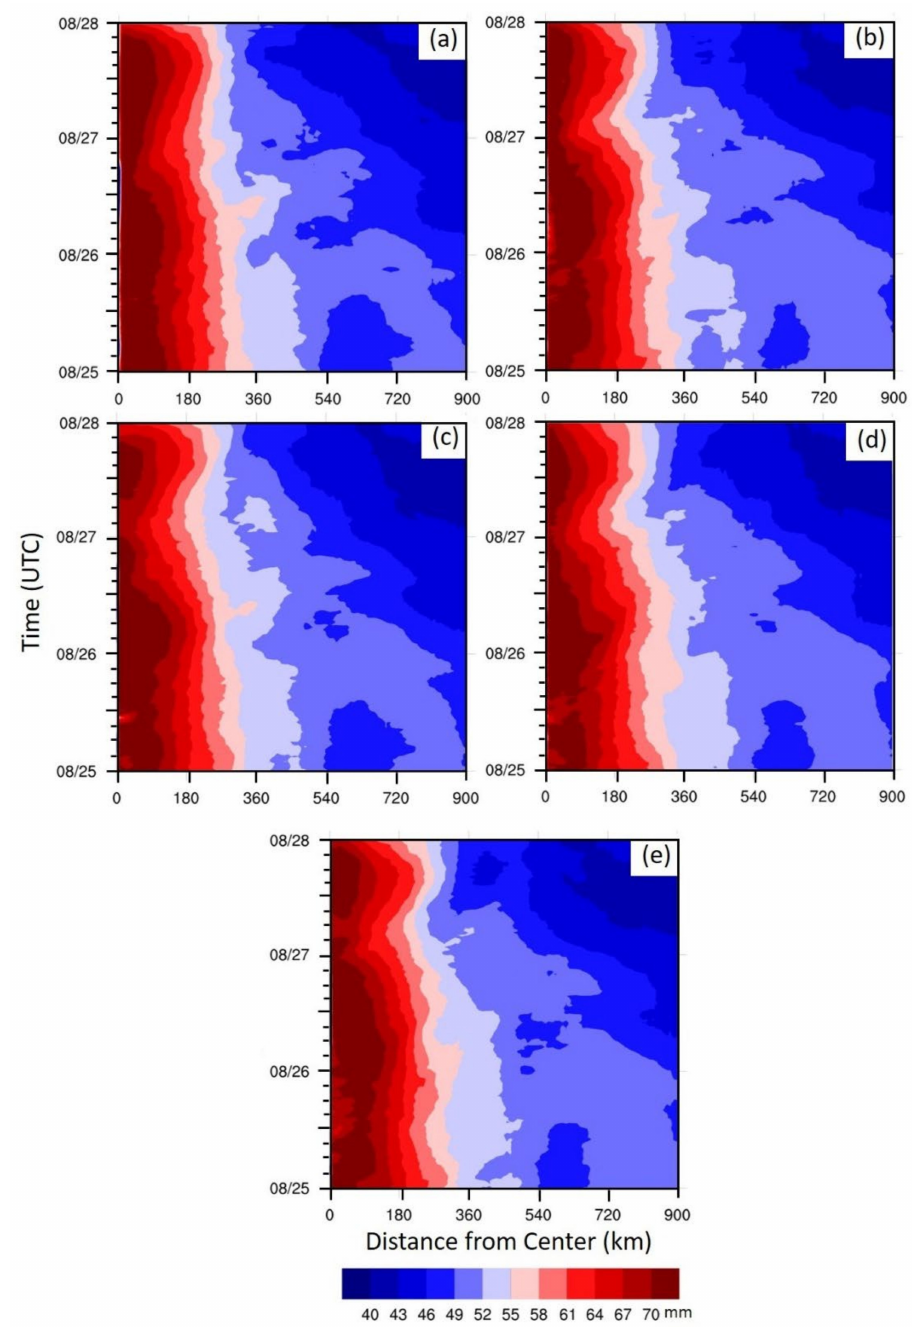
Figure 6. Hovmöller diagram showing TPW averaged around the storm from 25 August to 28 August for ( a ) DS case; ( b ) WS case; ( c ) DR case; ( d ) WR case; ( e ) Control